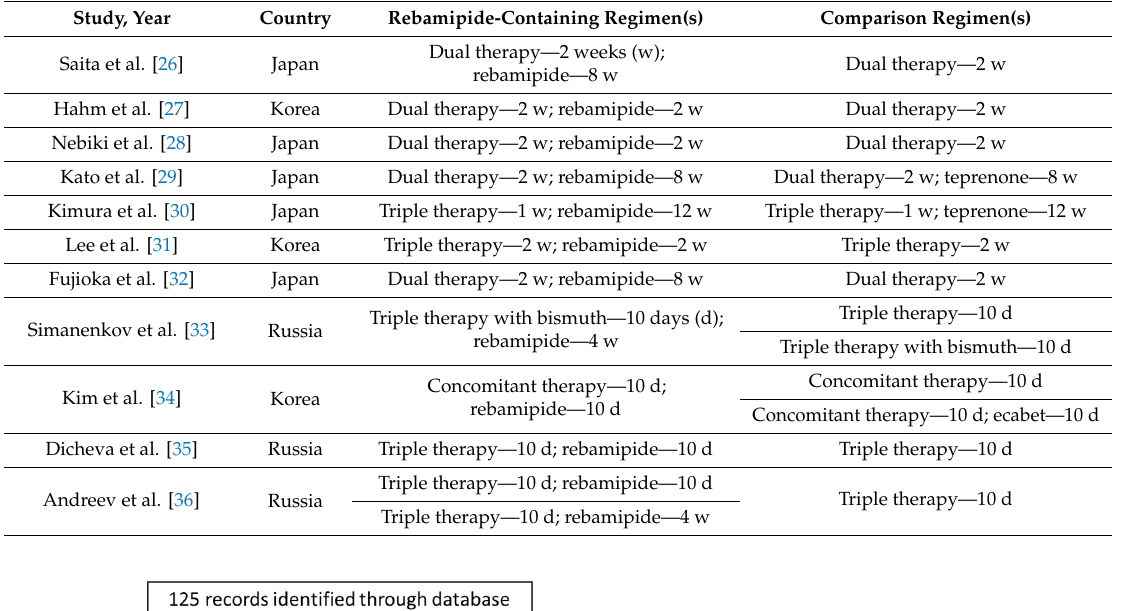
Table 1. Characteristics of the selected studies.